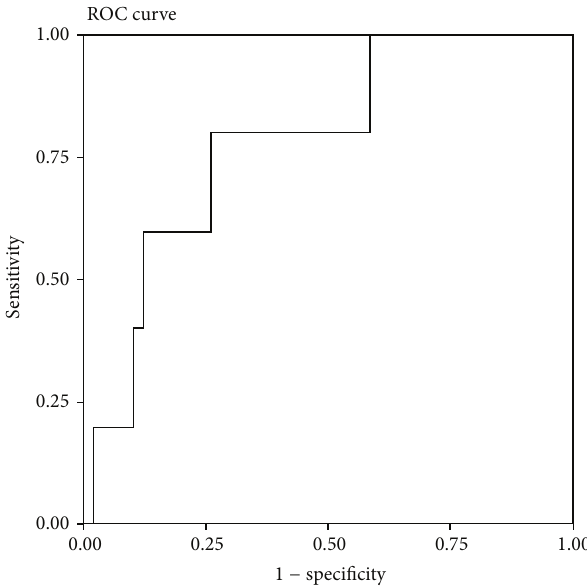
Figure 1: Receiver operating characteristic curve of different plasma clusterin concentrations before and after intravenous immunoglob- ulin (IVIG) infusion (CLUSTER 12) for the prediction of IVIG resistance in patients ( 𝑁 = 68 ) with Kawasaki disease.